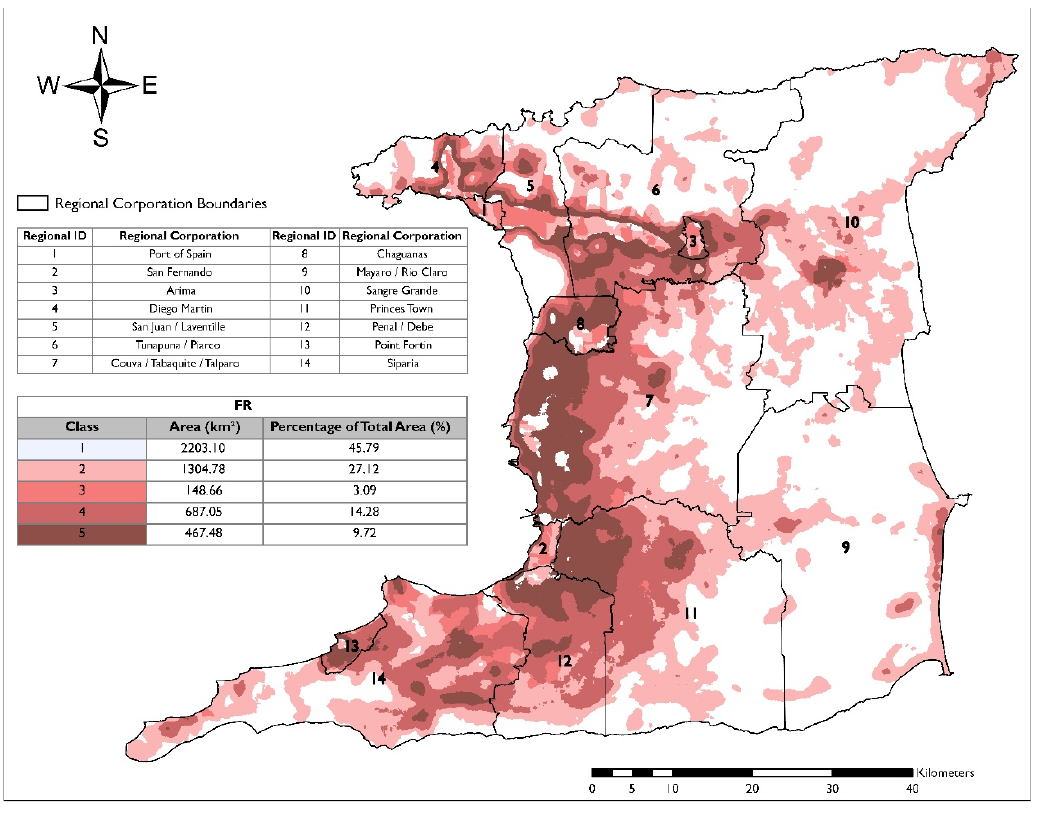
Figure 11. Vulnerability Indexes created for FR.